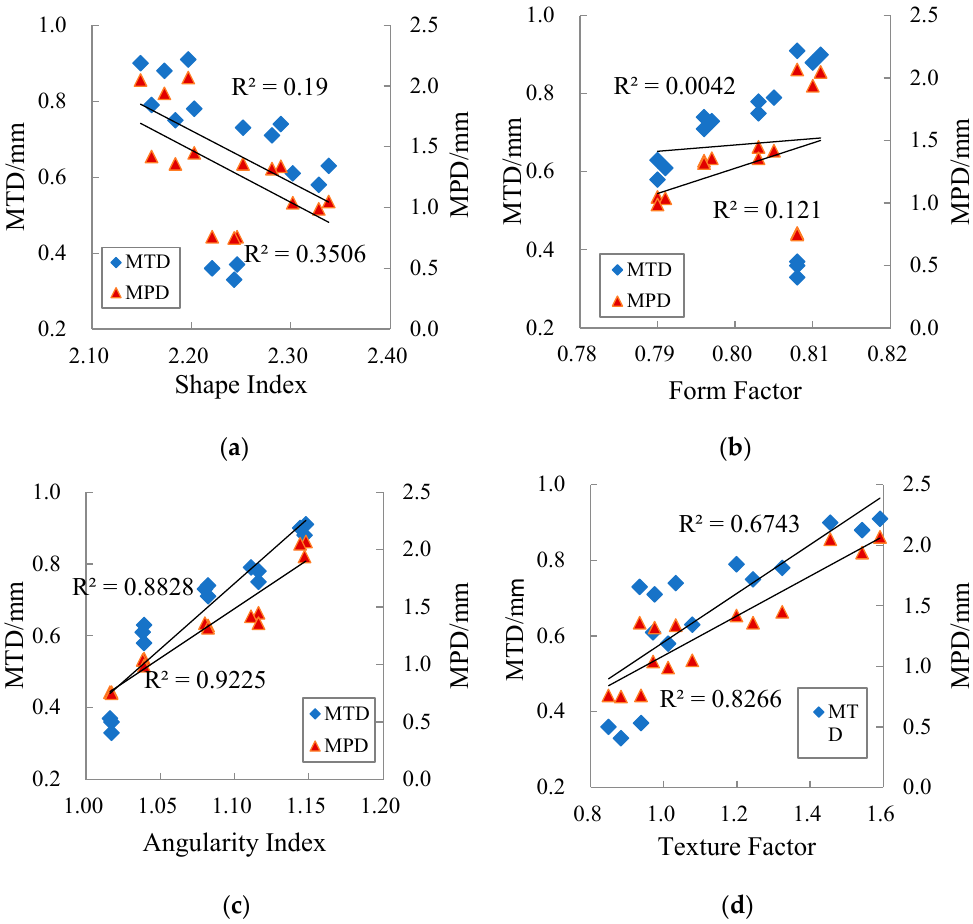
Figure 10. Correlation between MTD/ MPD and four aggregate geometric characteristic parameters: ( a ) Average shape index, ( b ) Average form factor, ( c ) Average angularity index, ( d ) Average texture factor.